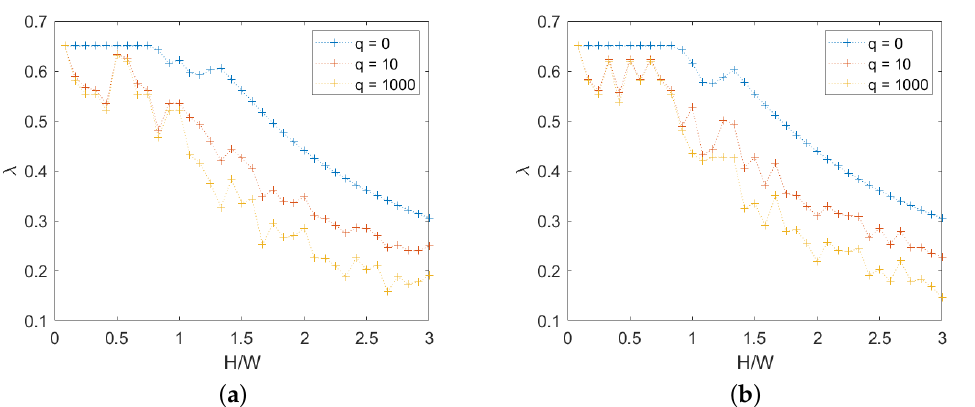
Figure 7. Quasi-periodic masonry, failure multipliers for different q : ( a ) right-oriented force, ( b ) left-oriented force.